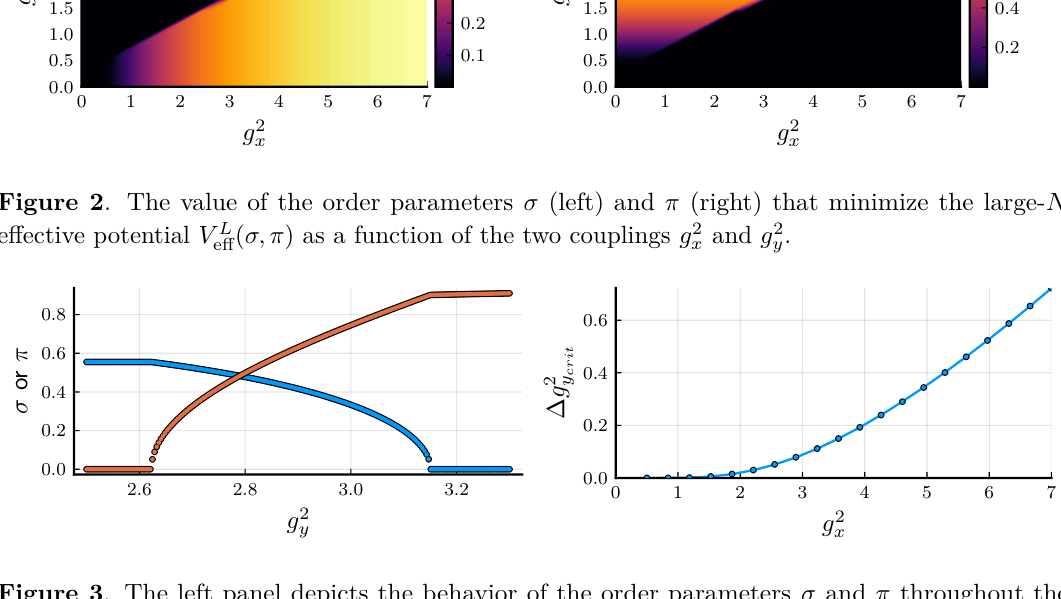
Figure 3 . The left panel depicts the behavior of the order parameters σ and π throughout the phase transitions for fixed g 2 = 6 . Here we can clearly see that there is a coexistence phase where x both order parameters are nonzero. The right panel plots the width of this coexistence region as a function of g 2 . The fitted curve is of the form ∆ g 2 ∝ g 2 exp( − 2 π/g 2 ) x y x x